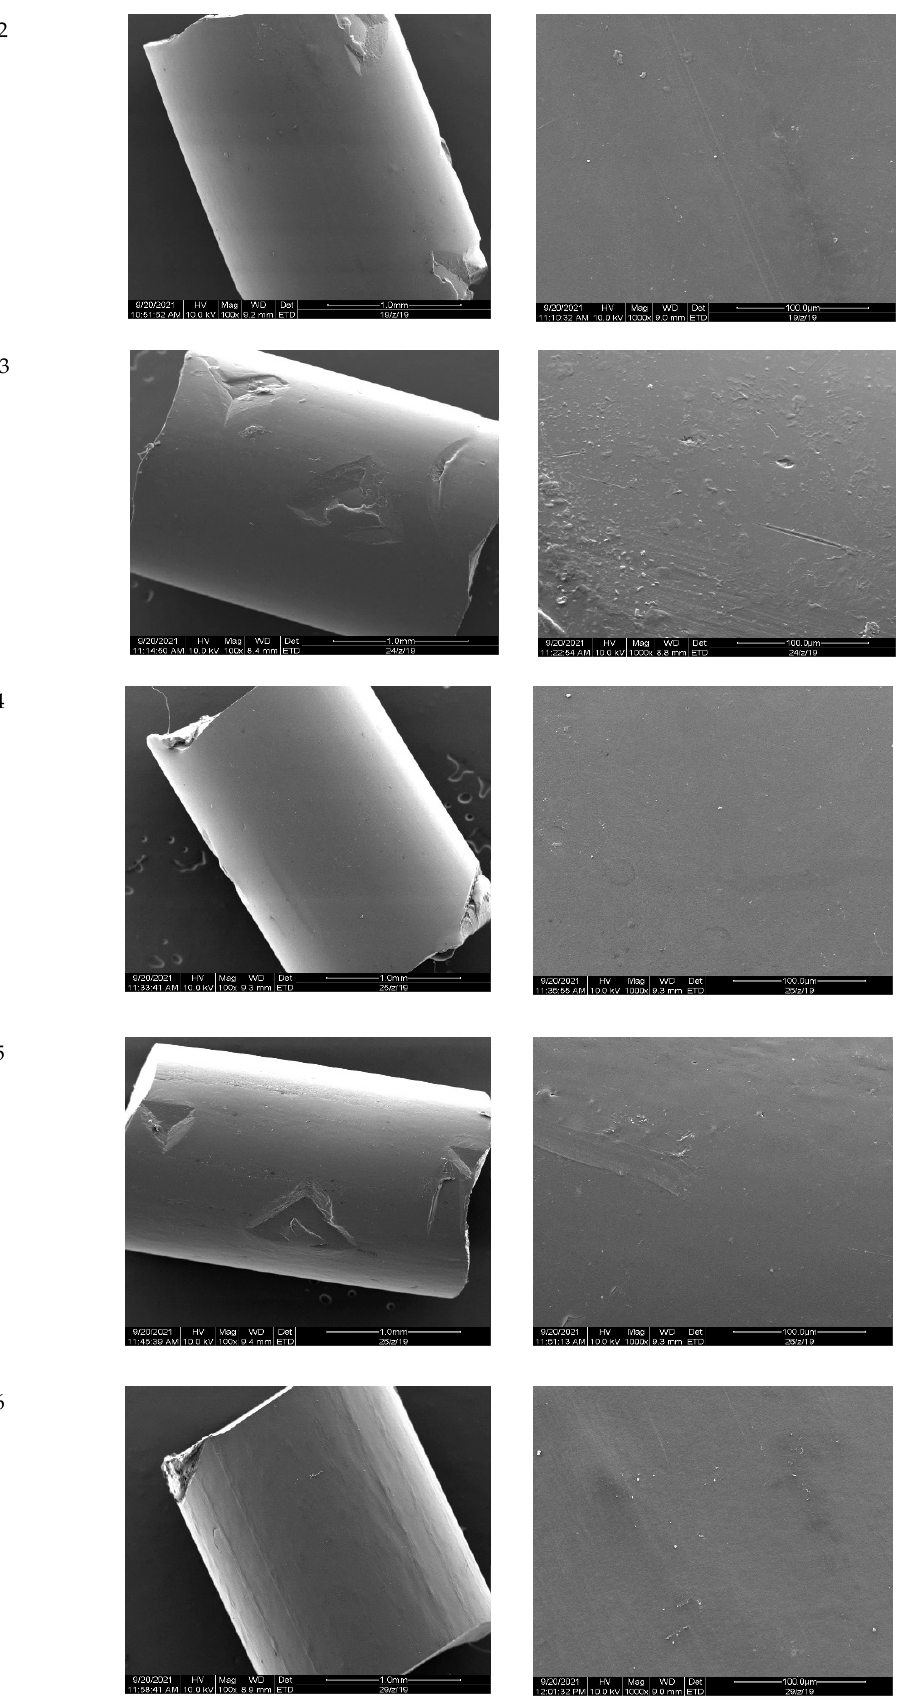
Figure 12. SEM pictures (magnification of 100 and 1000 times).